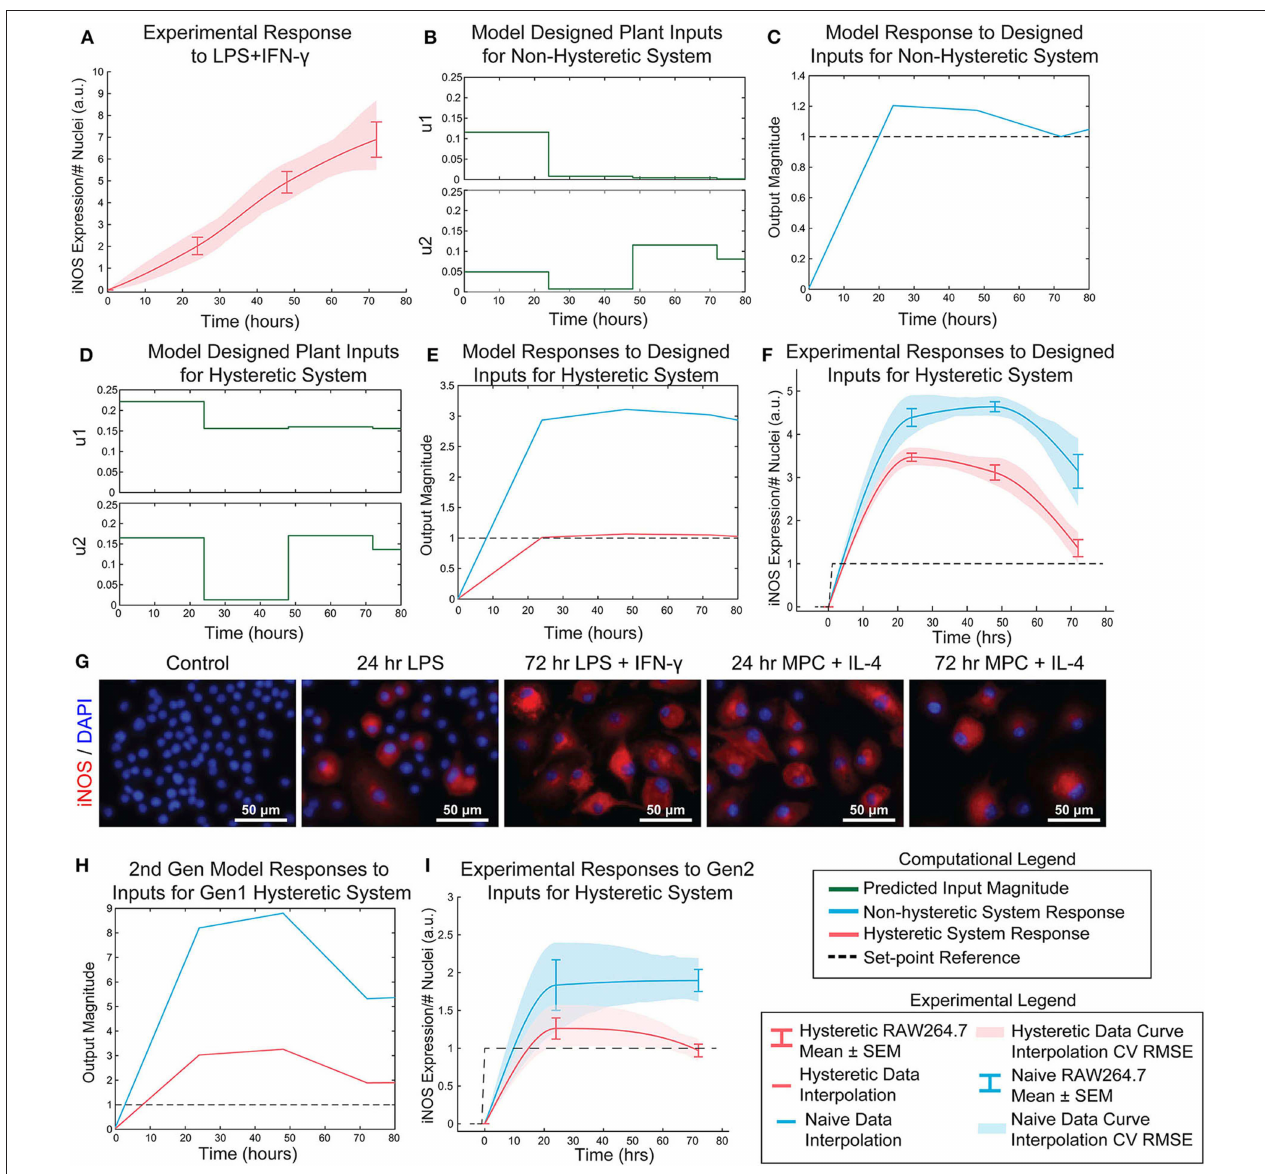
FIGURE 6 | Open-loop control of pro-inflammatory macrophage activity is experimentally achieved using a nested multiple regression. (A) RAW 264.7 macrophage temporal response to 1 µ g/mL LPS and 100ng/mL IFN- γ . (B) Model designed inputs u 1 and u 2 using hysteresis-free model, which reflects cells beginning in a naïve state. (C) Hysteresis-free model response to inputs defined in (B) . (D) Model designed inputs u 1 and u 2 using first generation model accounting for hysteresis, which reflects cells starting from a non-naïve 24h IL-4 primed state. (E) Hysteretic model (red) and non-hysteretic model (blue) responses to inputs defined in (D) . (F) Experimental delivery of designed inputs in (D) reflects predicted control output (E) for both hysteretic IL-4 primed (red curve, mean ± SEM, N = 16; interpolated curve ± RMS CV error) and non-hysteretic (blue curve, mean ± SEM, N = 16; interpolated curve ± RMS CV error) RAW 264.7 macrophage cultures. (G) Representative images of iNOS staining in model predictive control experiments using the inputs in (D) . (H) Simulation of updated 2nd generation model with dynamic supra-additivity term in response to designed inputs (D) captures experimental RAW 264.7 iNOS expression for both hysteretic (red curve) and non-hysteretic (blue curve) systems. (I) Experimental validation of the second-generation global model. Delivery of inputs designed to maintain a constant unit output of iNOS in a hysteretic system using the new model (inputs shown in Figure S6 ) improves control output for both hysteretic IL-4 primed (red curve, mean ± SEM, N = 8; interpolated curve ± RMS CV error) and non-hysteretic (blue curve, mean ± SEM, N = 8; interpolated curve ± RMS CV error) macrophage cultures.